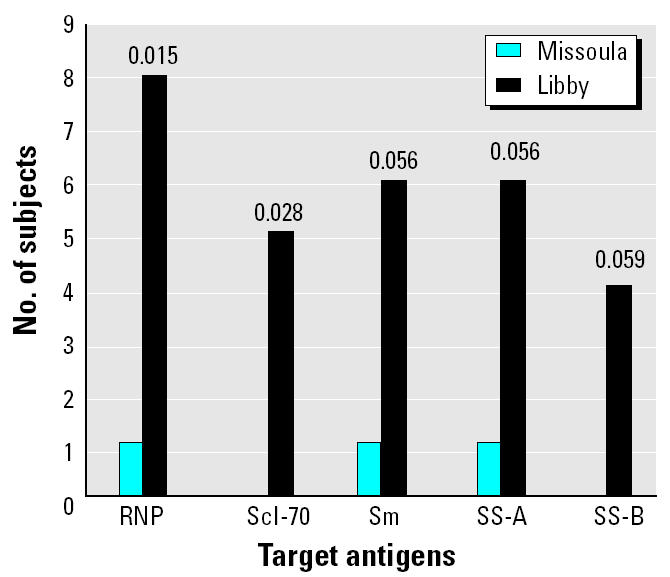
Increased frequency of positive ENA tests in Libby samples compared with Missoula samples. Tests were performed as described in “Materials and Methods.” Numbers above the bars are p-values indicating the statistical difference between Libby samples and Missoula samples (determined by Fisher’s exact test; n = 50).